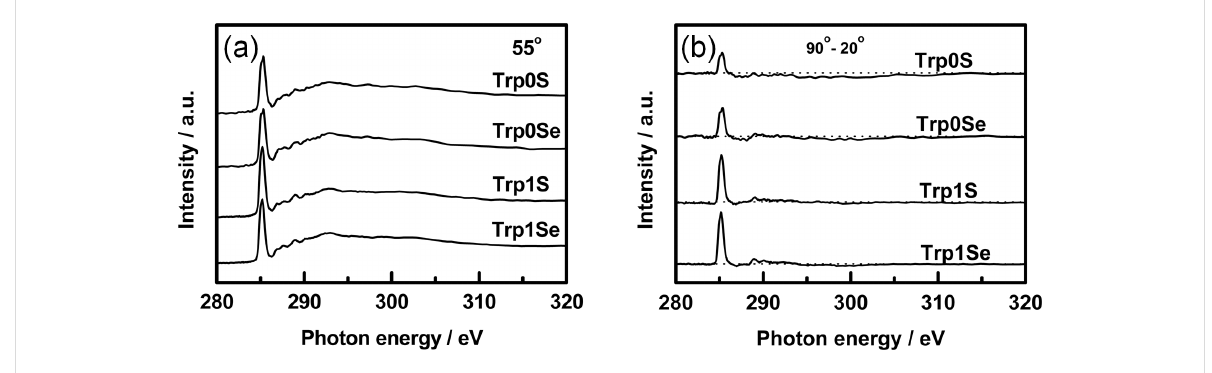
Figure 5: Carbon K-edge NEXAFS spectra of Trp0S-, Trp0Se-, Trp1S- and Trp1Se-SAMs on Au(111). (a) Recorded at an X-ray incidence angle of 55°. (b) Difference between the spectra recorded at X-ray incidence angles of 90° and 20°. The horizontal dotted lines correspond to zero.